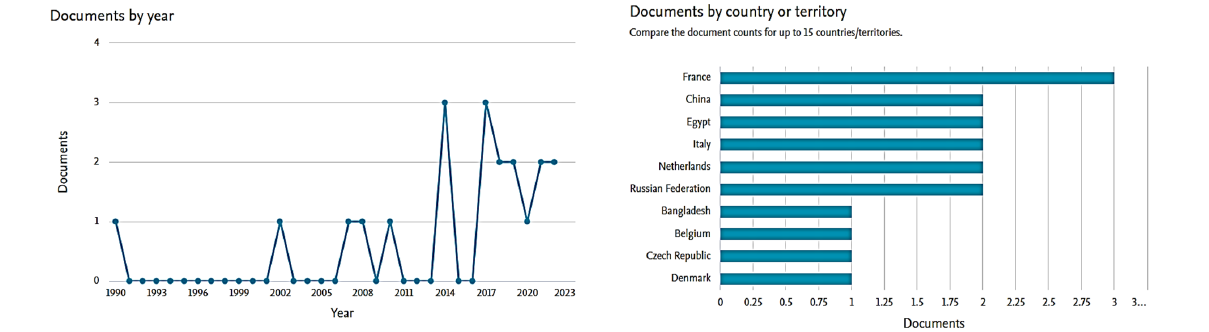
Fig. 3. Analysis and evolution of the words “brick” and “humidity” Source: Scopus scientific review.